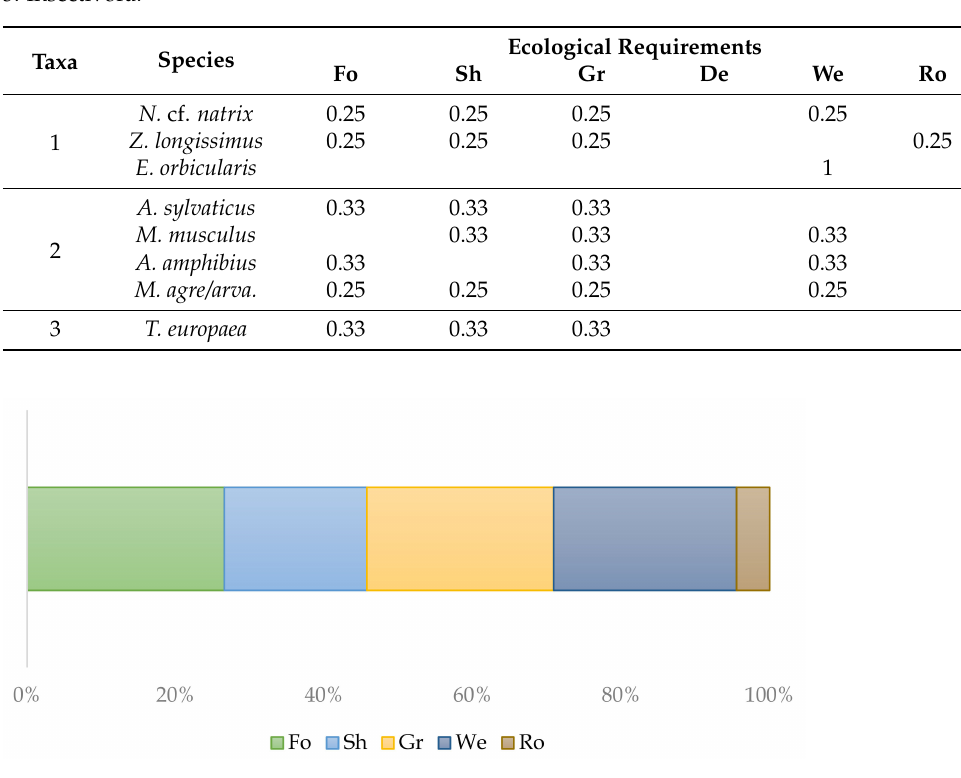
Figure 7. Based on NMI, results of the habitat weighting method for the microvertebrate assemblage at Borsodiv á nka (2020 campaign): Forest (Fo), Shrubland (Sh), Grassland (Gr), Wetland (We), and Rocky